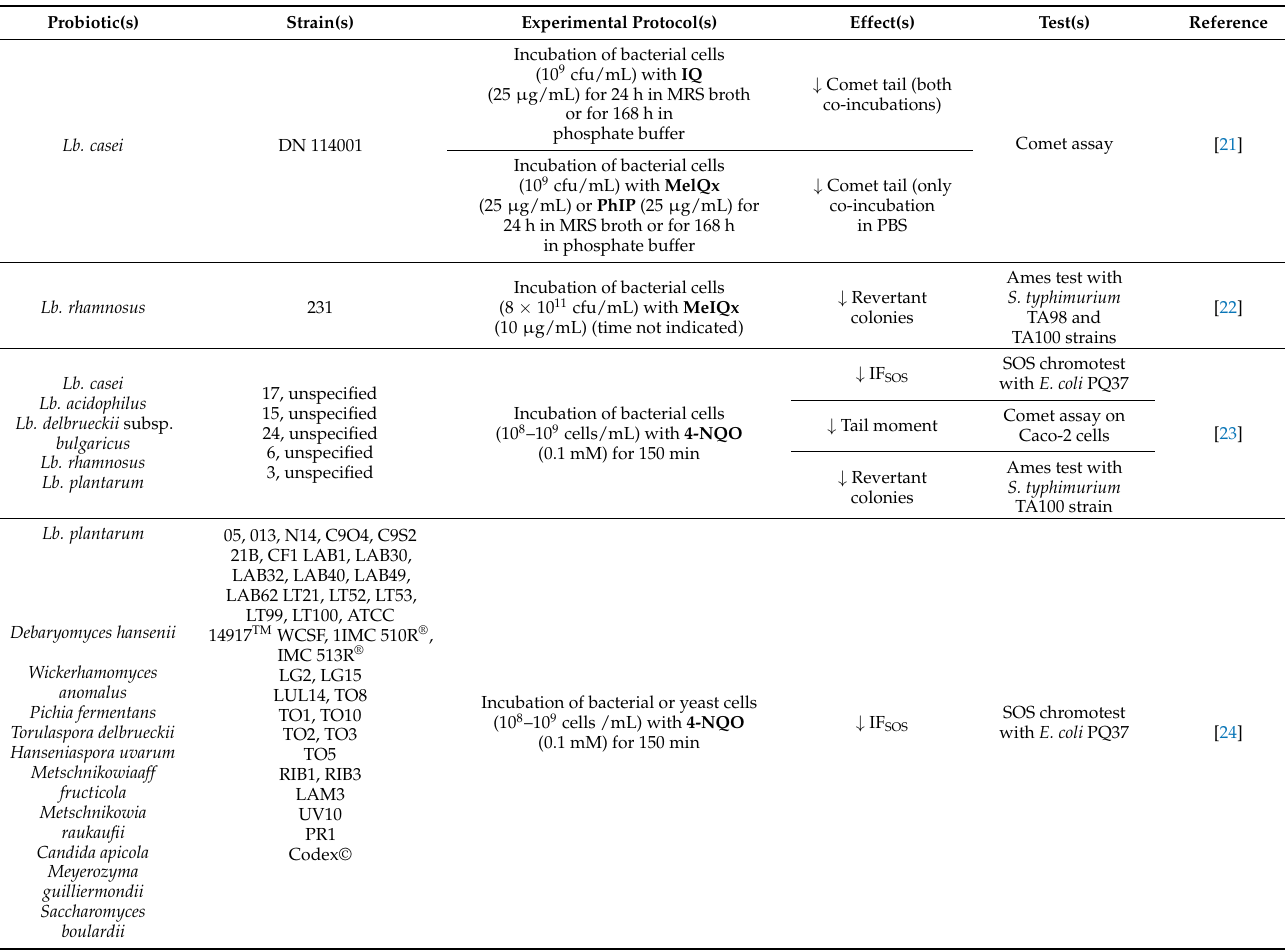
Table 1. In vitro antigenotoxic activity of